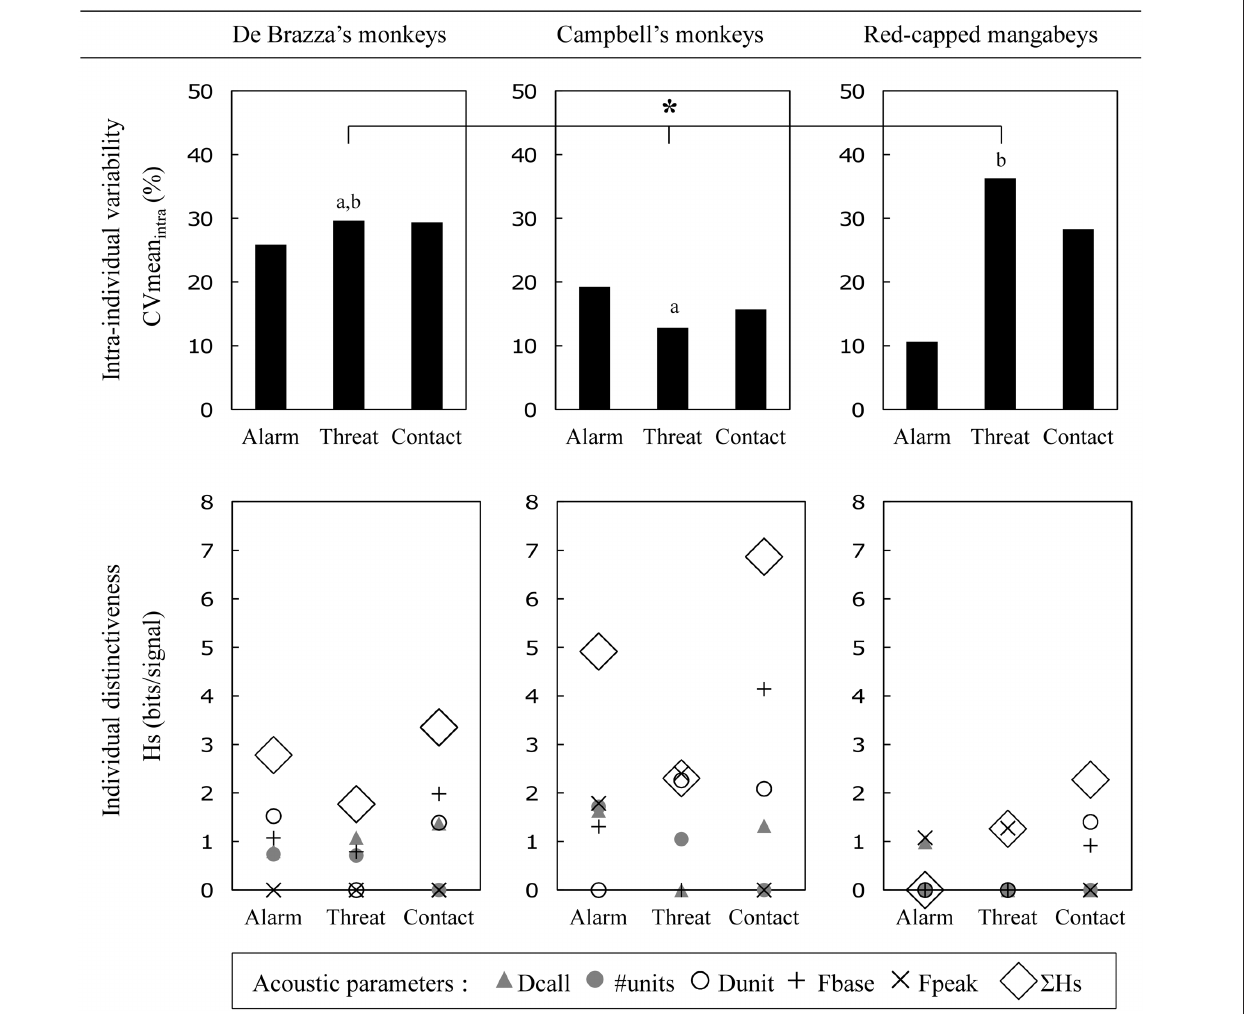
letters symbolizing homogeneous subsets). Hs : information content value (see the Statistical Analysis section for definitions). Dcall, call duration (ms); #units, number of units; Dunit, unit duration (ms); Fbase, unit base frequency (Hz); and Fpeak, unit peak frequency